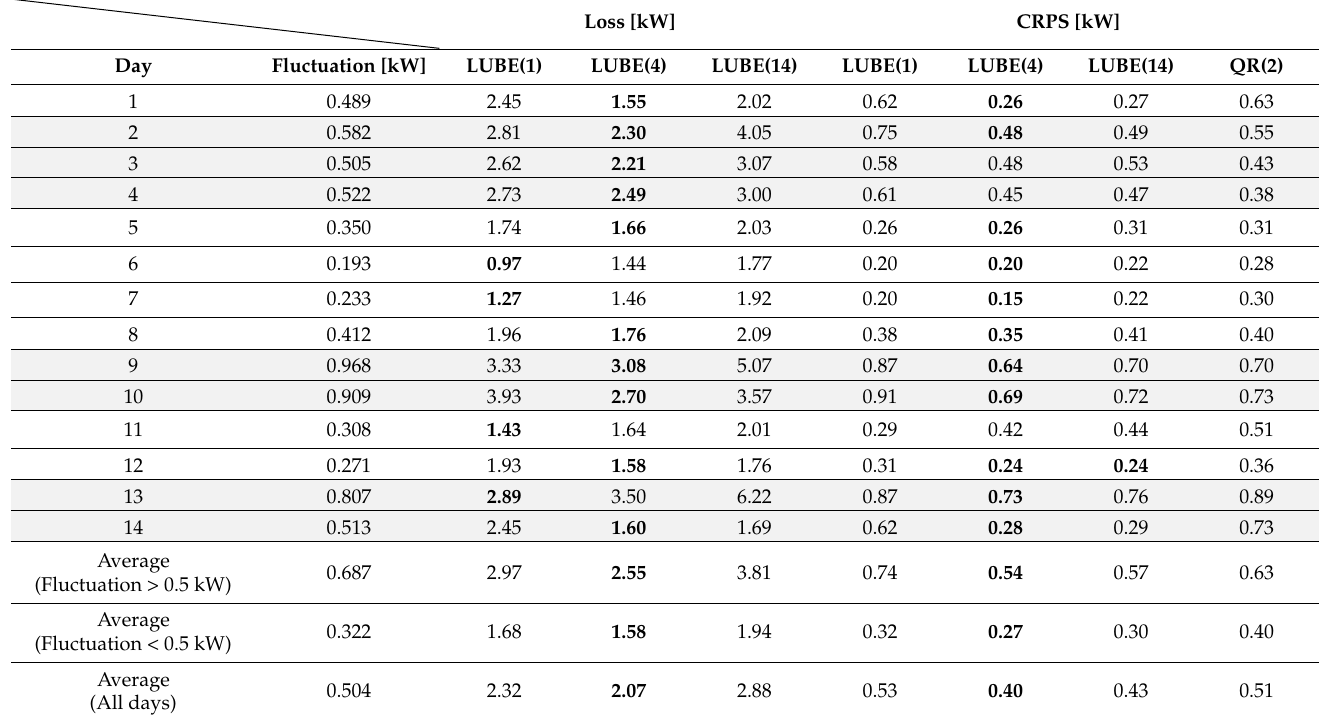
Table 8. Evaluation for LUBE (1), (4), (14) and QR (2) by Loss and CRPS from June 1 to 14.